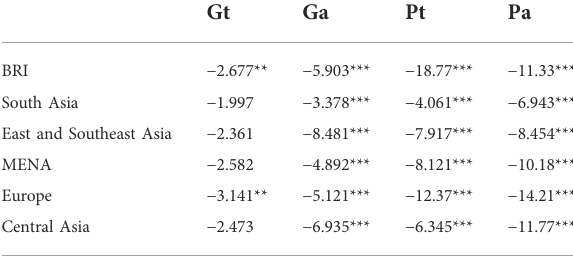
TABLE 6 Results of Westerlund cointegration test.